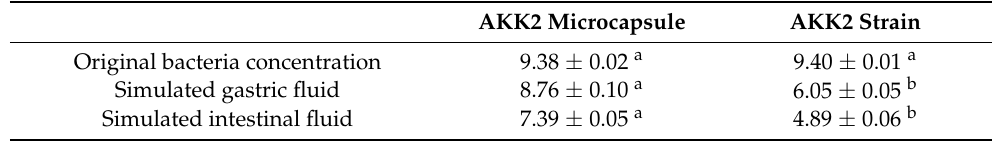
Table 6. The releasing test in simulated gastric-intestinal fluid lg